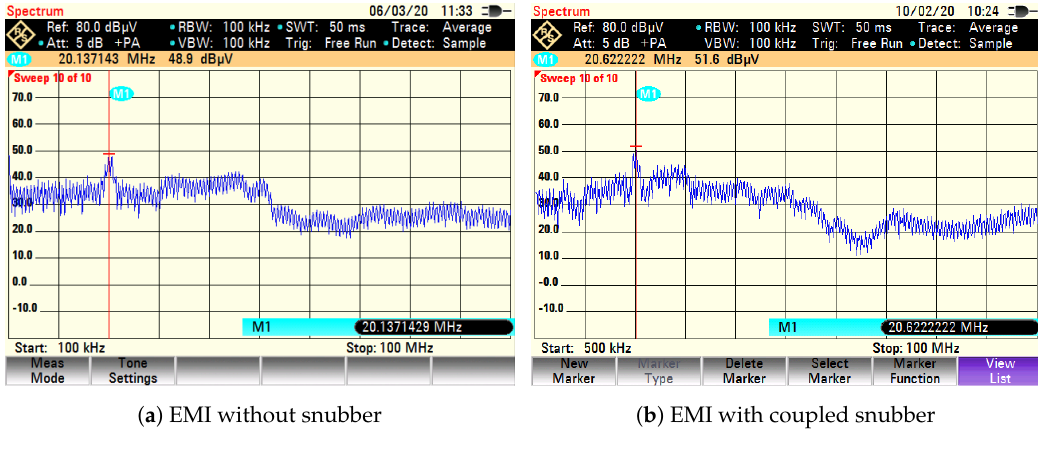
Figure 20. EMI for the SEPIC converter “ V in = 24